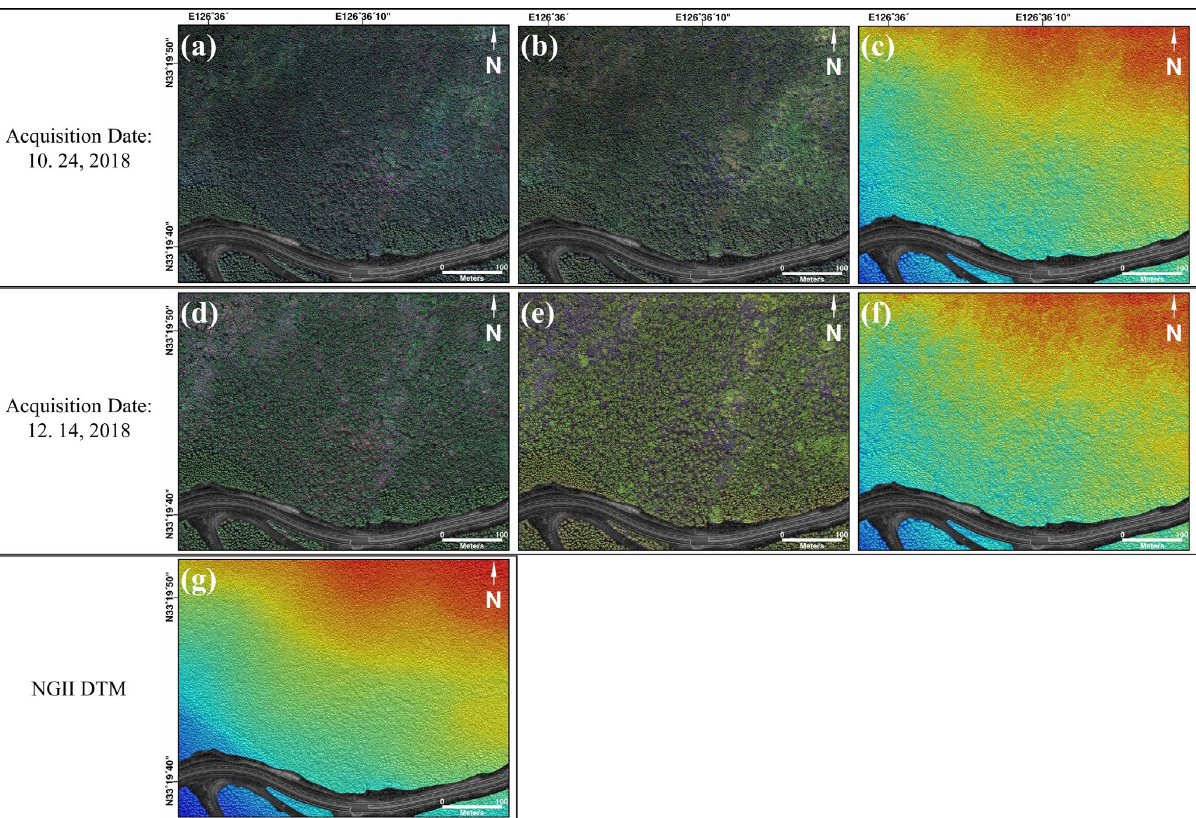
Figure 4. ( a ) True color composite image (R, G, B), ( b ) false color composite image (red edge, NIR, B), and ( c ) LiDAR DSM obtained on 24 October 2018; ( d ) true color composite image (R, G, B), ( e ) false color composite image (red edge, NIR, B), and ( f ) LiDAR DSM obtained on 14 December 2018; and ( g ) NGII DTM.